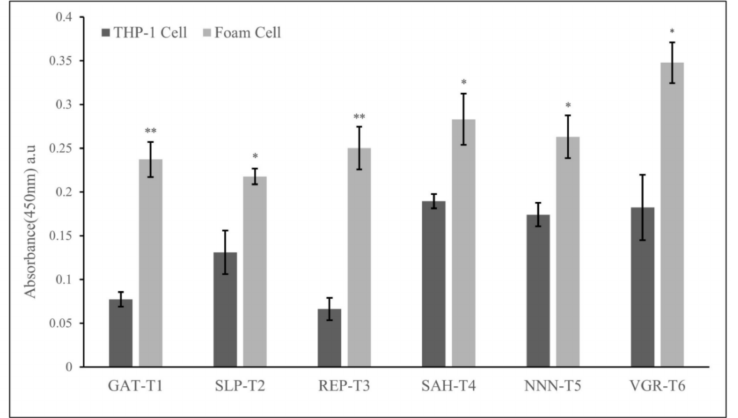
Figure 7. The ELISA results of polypeptide specificity, * represents p value range in t -test, * = 0.05, ** = 0.001.